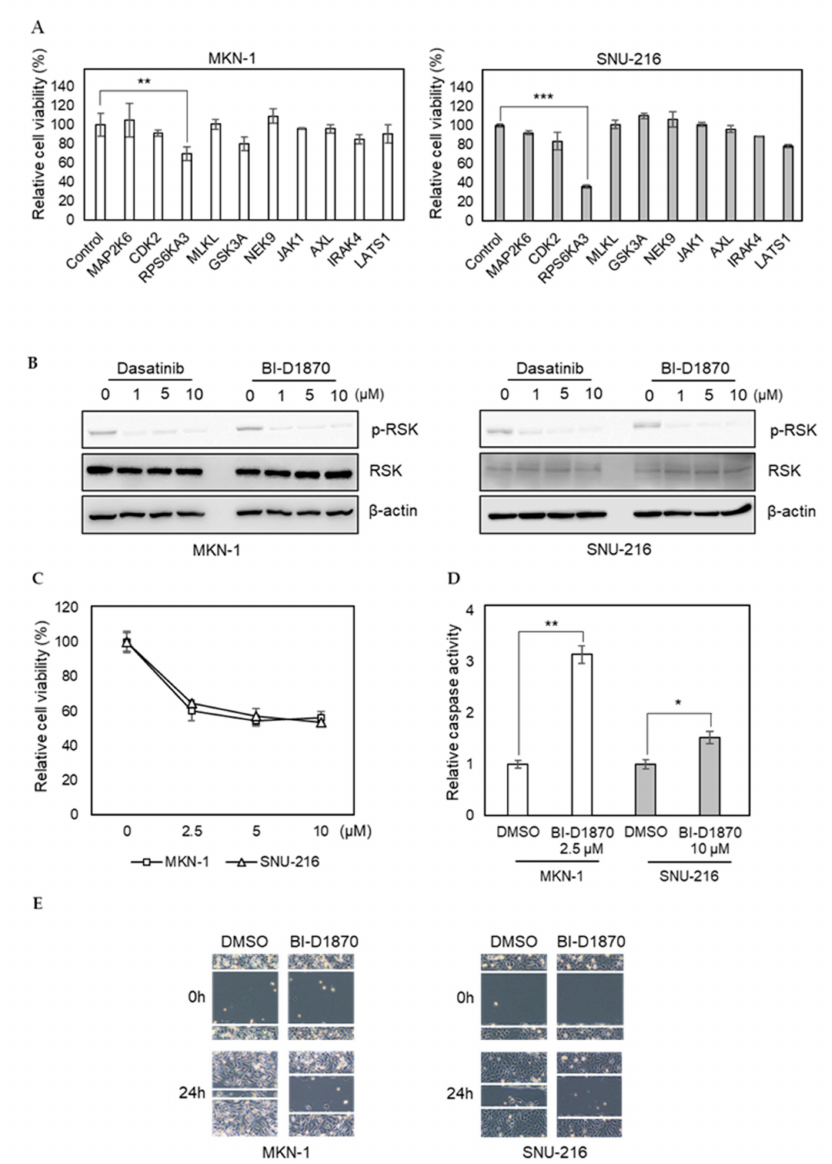
Figure 5. RNAi screen identifies p90RSK as a novel dasatinib target and it is important for GC cell viability and motility. ( A ) Relative viabilities of GC cells in response to siRNA transfection. The cell viability was assessed by MTT assay. Error bars represent standard deviation from representative triplicate experiments from two experiments that showed similar results. ** p < 0.01, *** p < 0.001. ( B ) Cells were treated with di ff erent doses of drugs (0 to 10 µ M) for 1 h, and phospho-RSK (T359) or total RSK levels were analyzed by Western blotting. ( C ) Relative viabilities of GC cells in response to BI-D1870 exposure. Cells were treated with di ff erent doses of drugs (0 to 10 µ M) for 72 h, and the cell viability was assessed by MTT assay. Error bars represent standard deviation from representative triplicate experiments from at least three experiments that showed similar results. ( D ) Cells were treated with 10 µ M of BI-D1870 for 24 h, then caspase activity was analyzed using a Caspase Glo 3 / 7 assay kit. Relative caspase activities are shown. Error bars represent standard deviation from representative triplicate experiments from two experiments that showed similar results. * p < 0.05, ** p < 0.01. ( E ) Cells were treated with vehicle control (DMSO) or 5 µ M of BI-D1870 for 24 h, then cell migration was analyzed by wound healing